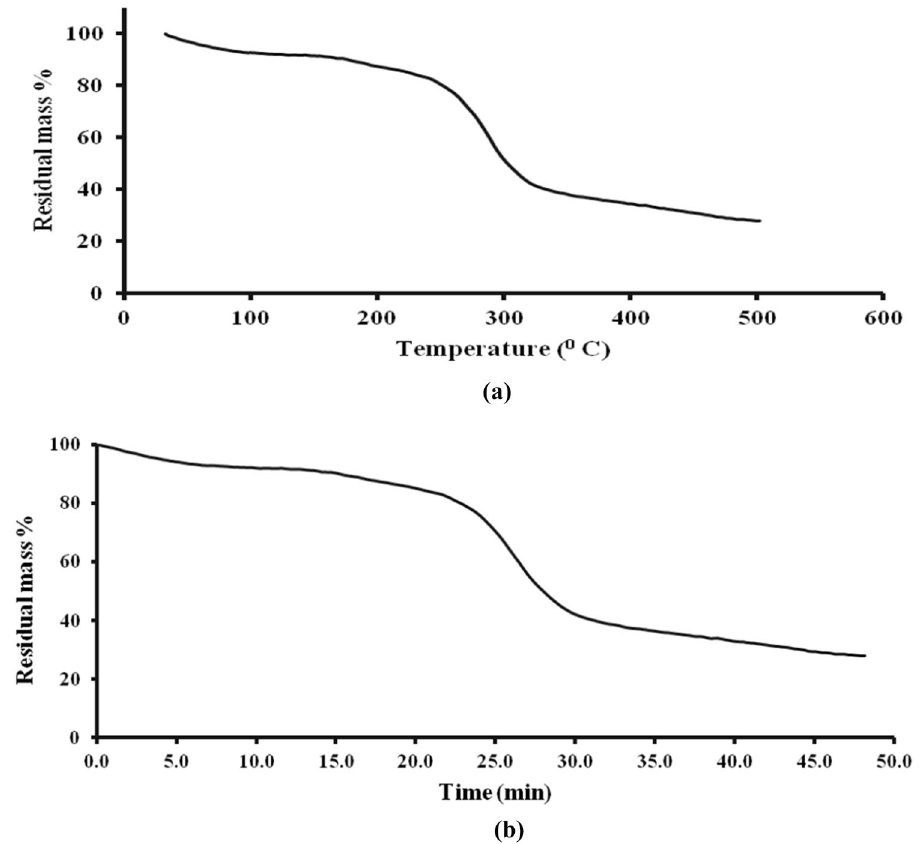
Fig. 2 a Residual mass percent- age of banana tree dust with temperature as obtained from TGA. b Residual mass percent- age of banana tree dust with time as obtained from